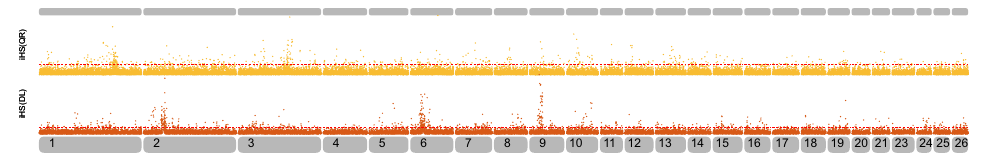
Figure 5. iHS Manhattan chart of QR and DL sheep breeds. The X-axis represents the chromosome, and the Y-axis represents the IHS value. The yellow part represents QR, and red represents DL. The red dashed line is the 1% threshold line.